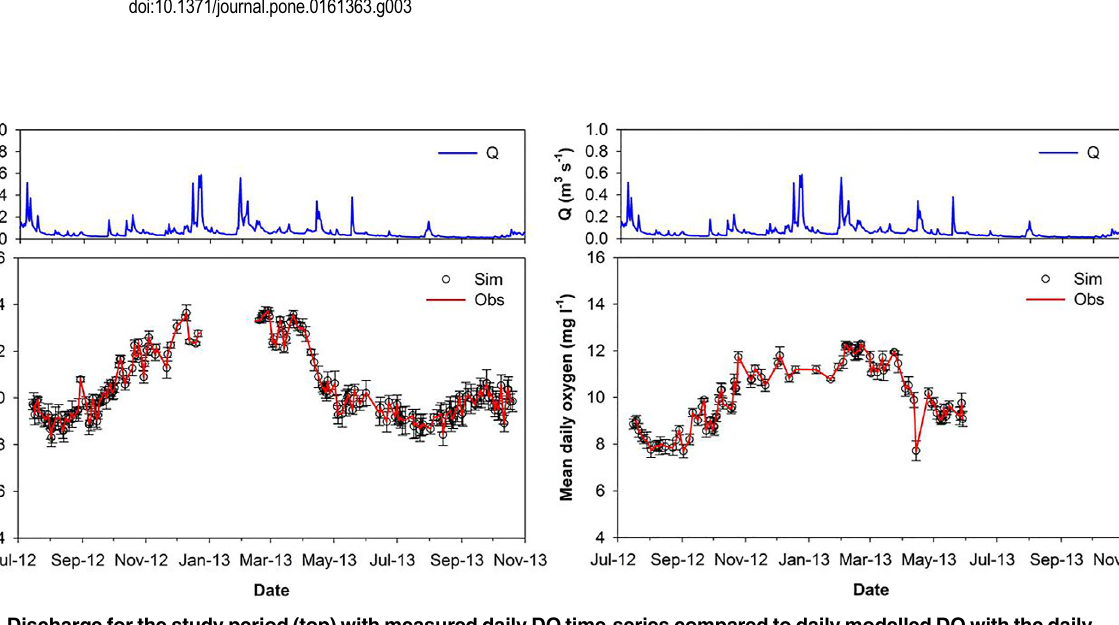
PLOS ONE | DOI:10.1371/journal.pone.0161363 August 24,